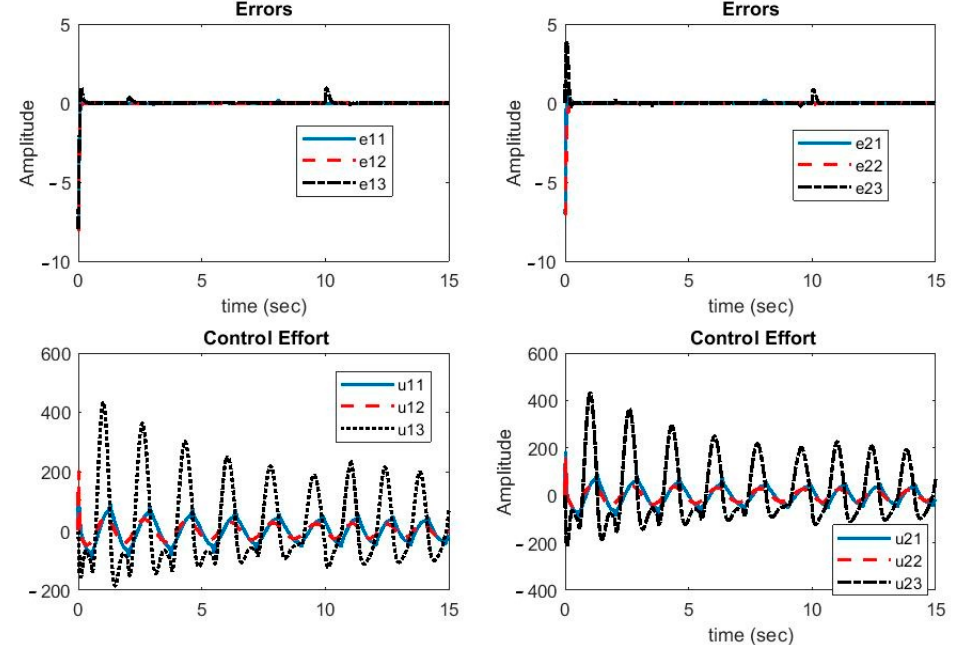
Figure 3. Plots of synchronization errors and control efforts.